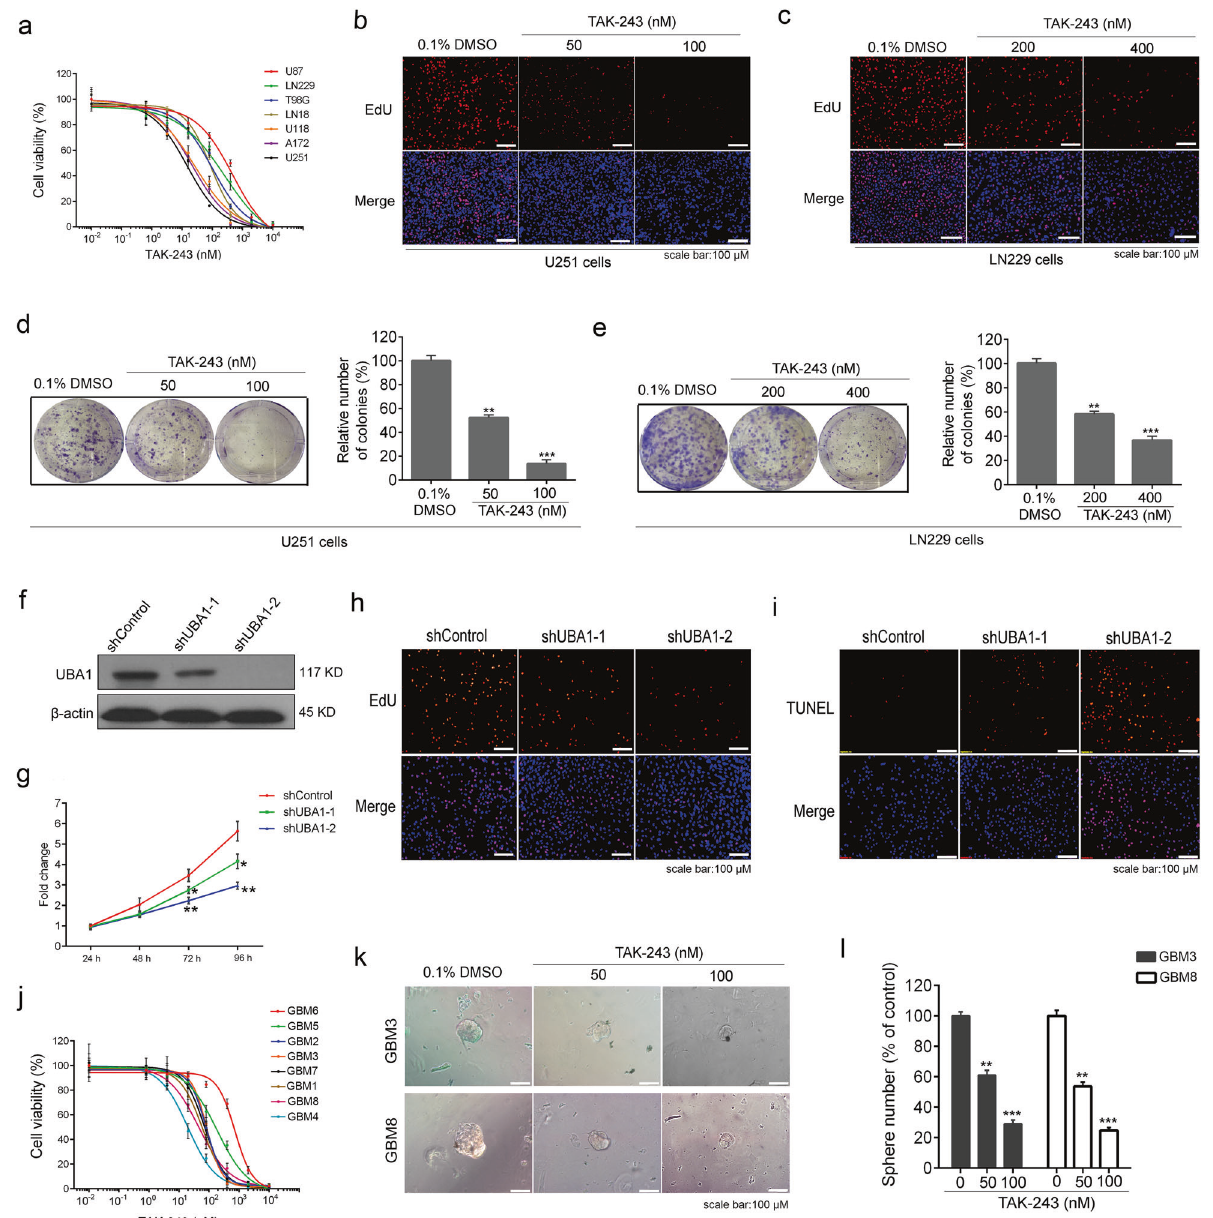
Fig. 1 TAK-243 inhibits cell proliferation and colony formation in GBM and primary GBM cells. a GBM cell lines were treated with increasing concentrations of TAK-243 (0 – 10 μ M) for 72 h. Cell viability was then measured by CCK-8 assay. b , c Measurement of antiproliferation effects of TAK-243 by EdU incorporation assay, scale bar: 100 μ m. d , e TAK-243 inhibits colony formation in U251 and LN229 cells in a dose-dependent manner. Quantitative analysis of the results of the colony formation experiment was performed. f Construction of UBA1 downregulated-LN229 cell lines. The ef fi ciency of UBA1 downregulation was assessed by Western blotting assay. g Cell viabilities were measured after UBA1 downregulation by CCK-8 assay. h , i Assessment of antiproliferation and proapoptotic effects of UBA1 downregulation by EdU incorporation assay (scale bar: 100 μ m) and TUNEL staining (scale bar: 100 μ m). j Primary GBM cell lines were exposed to either 0.1% DMSO or TAK-243 for 72 h. Cell viability was then determined by CCK-8. k , i Colony formation abilities of primary cell lines were assessed by methylcellulose clonal assays (scale bar: 100 μ m). All the Data are presented as means ± SD. ** P < 0.01, *** P < 0.001 compared with the 0.1% DMSO treated